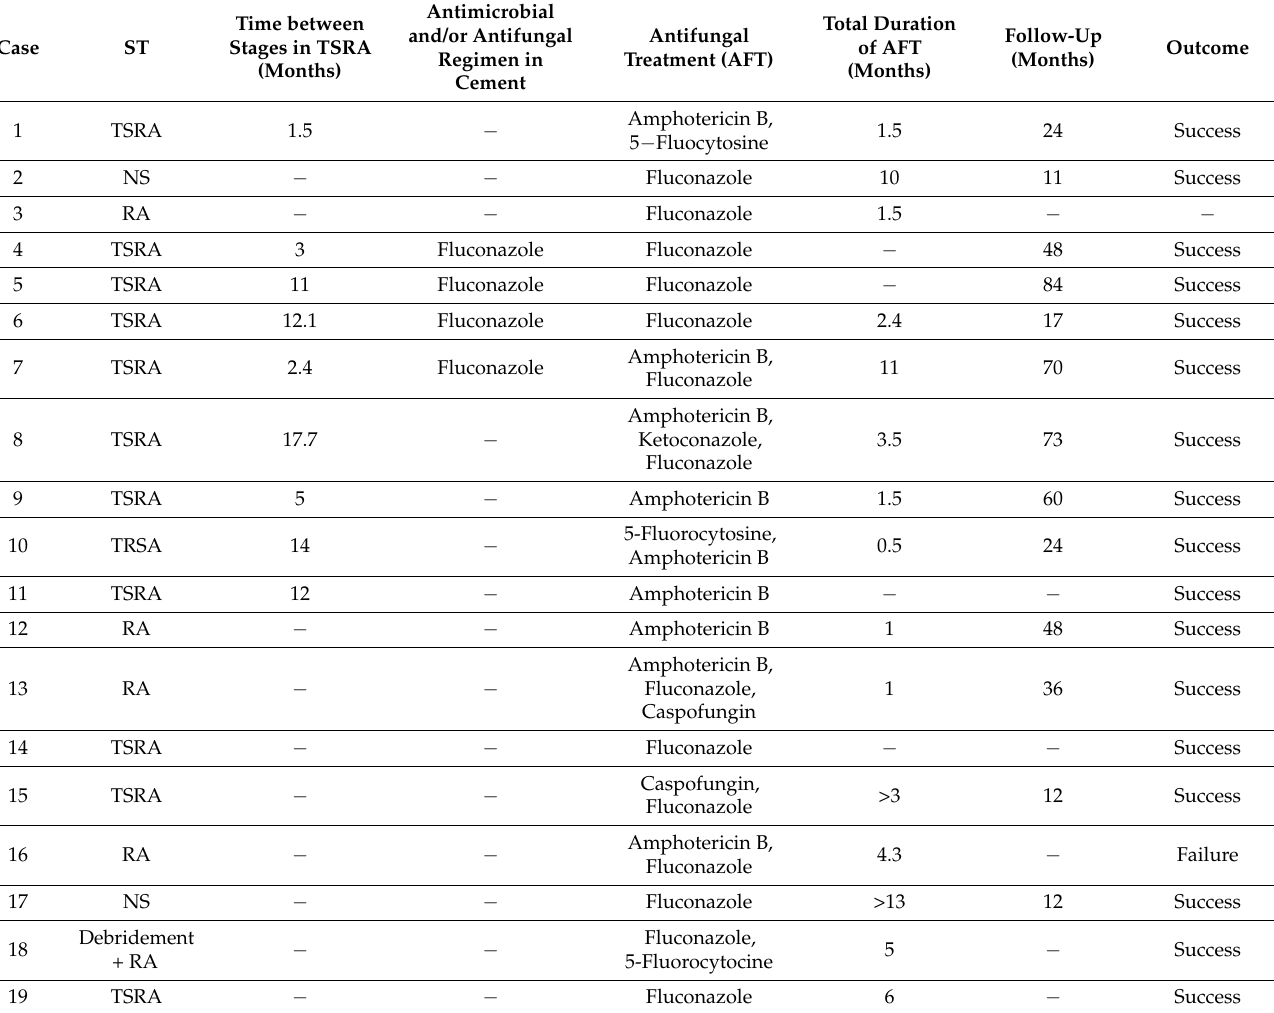
Table 3. Surgical and antifungal treatment, duration of AFT, follow-up and infection outcome of the reported cases. ST: surgical treatment, TSRA: two-stage revision arthroplasty, OSRA: one-stage revision arthroplasty, AFT: antifungal treatment, NS: no surgery, RA: resection arthroplasty, ( − ):